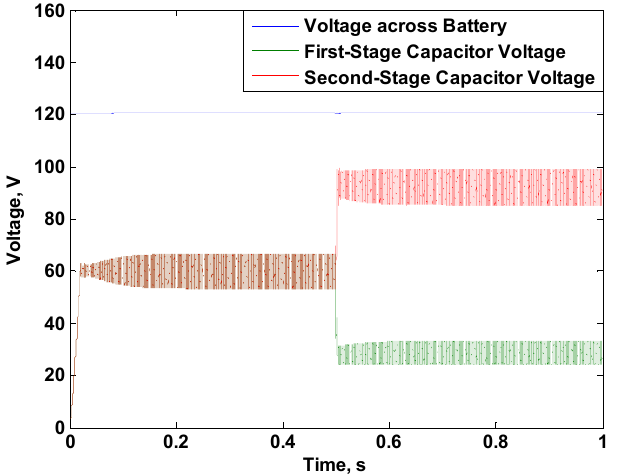
Figure 24. Charging current at a reference current of 5 A.